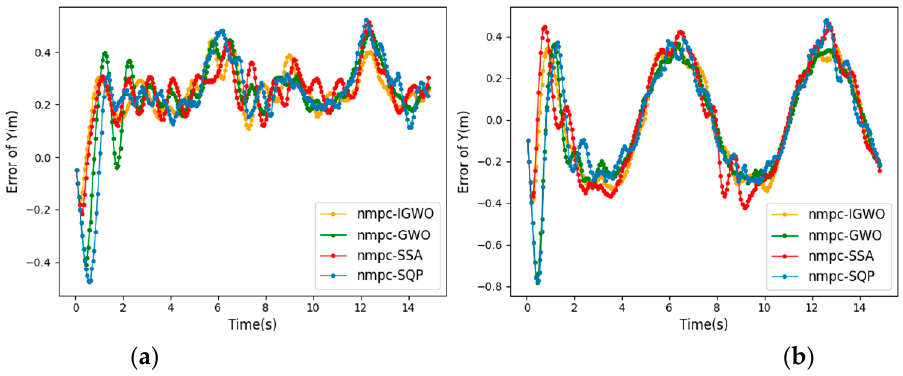
Figure 12. Comparison of x/y tracking error of IGWO, GWO and SSA algorithms: ( a ) error of x position; ( b ) error of y position.